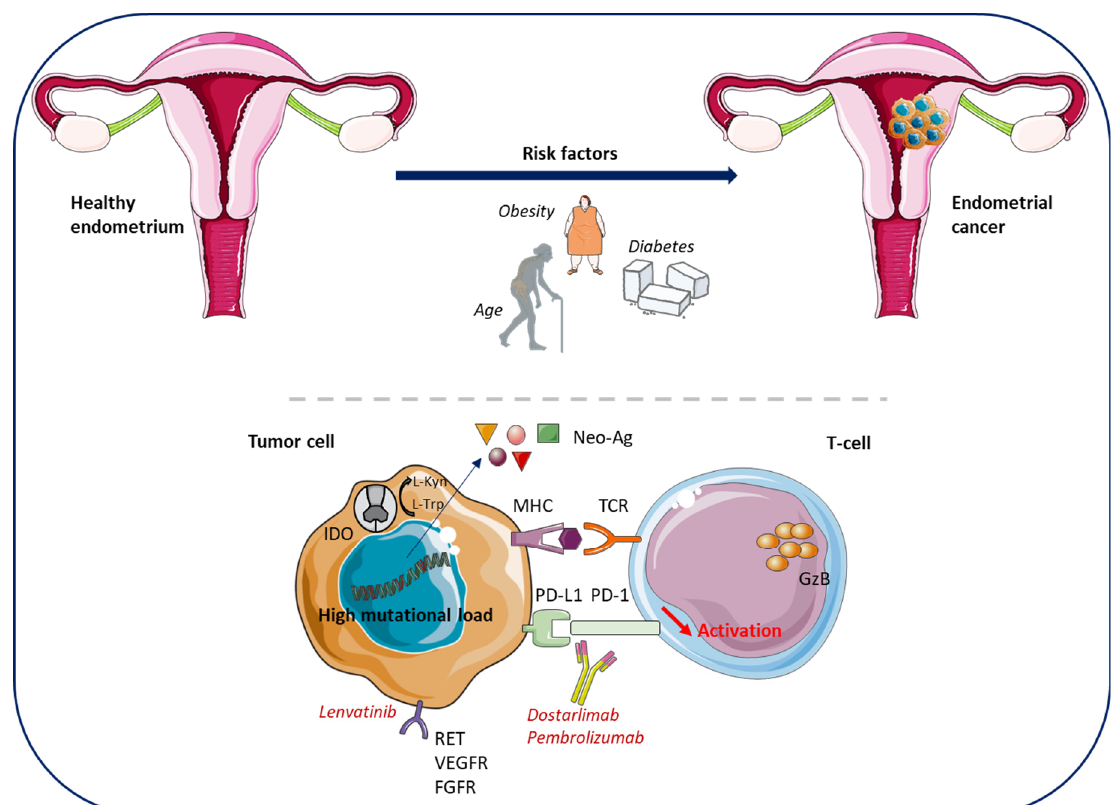
Figure 1. Endometrial cancer (EC) — development, immune environment and approved treatments. Risk factors linked to the development of EC include obesity, type 2 diabetes, prior breast or ovarian cancer, and age. The POLEmut and the MSI ‐ H subtypes of EC have a high mutational load resulting in tumor ‐ specific neo ‐ antigen production, favoring cytotoxic T cell infiltration within tumors. EC cells are known to express IDO that converts L ‐ Trp in L ‐ Kyn, driving regulatory T cells’ differentiation and inhibiting CD8 pos and NK cells. EC cells express high levels of RET, VEGFR, and FGFR that can be targeted with Lenvatinib. EC cells also express PD ‐ L1 and the use of Dostarlimab or Pembrolizumab, permitting the reactivation of the immune system and the anti ‐ tumor response. Ag, antigens; EC, endometrial cancer; FGFR, fibroblast growth factor receptor; GzB, granzyme B; IDO, indoleamine 2,3 ‐ dioxygenase; Kyn, kynurenine; MSI ‐ H, microsatellite instability hypermutated; POLEmut, polymerase ε mutation; RET, rearranged during transfection (tyrosine kinase receptor); Trp, tryptophan; VEGFR, vascular endothelial growth factor. The figure was drawn by using pictures from Servier Medical Art. Servier Medical Art by Servier is licensed under a Creative Commons Attribution 3.0 Unported License (https://creativecommons.org/licenses/by/3.0/ (accessed on 2 September